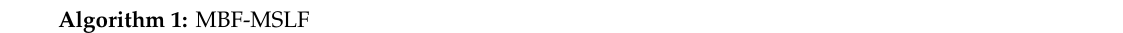
Algorithm 1: MBF-MSLF